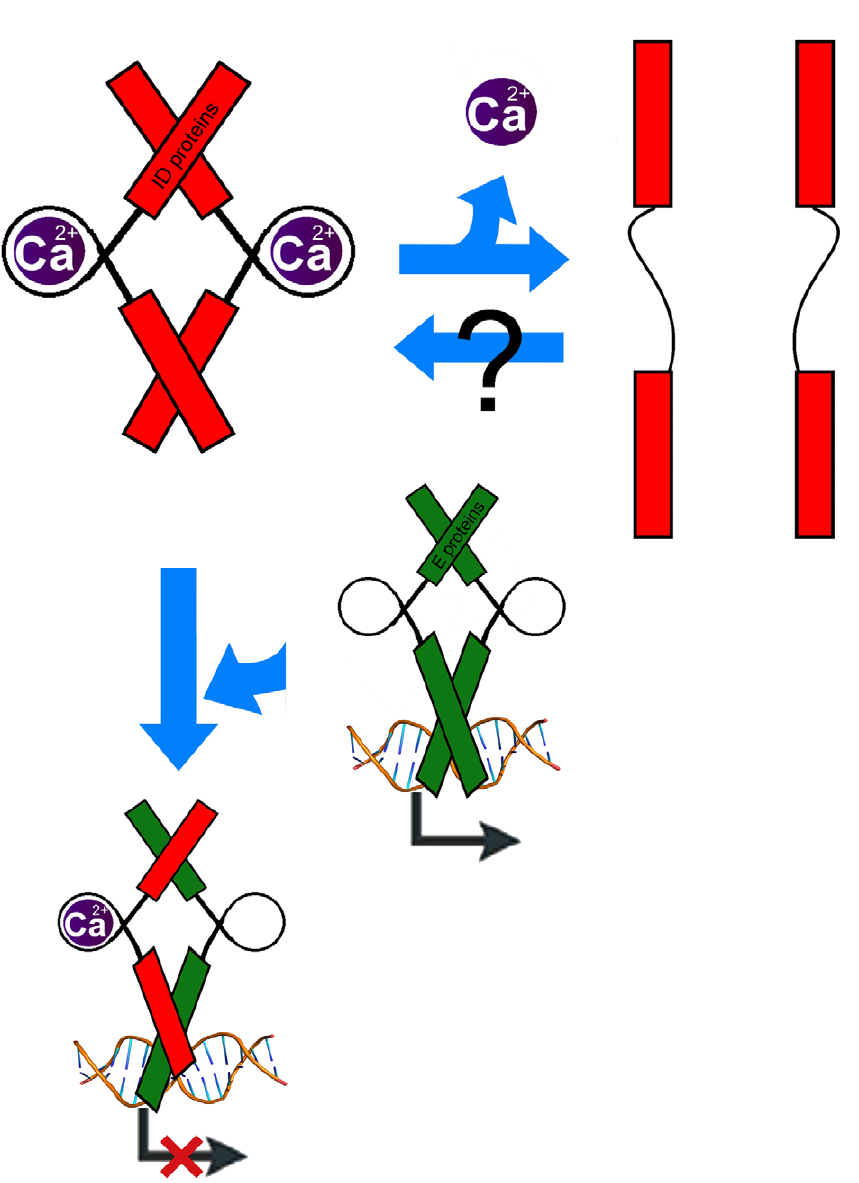
Figure 5. Proposed role of the Ca2 + ion in the structure and function of ID proteins. Ca2 + appears to have a role in allowing heterodimer recognition by the helical region of ID proteins. Addition of EGTA appears to inhibit heterdimerization, and hence the ability of ID proteins to recognize their binding partners.